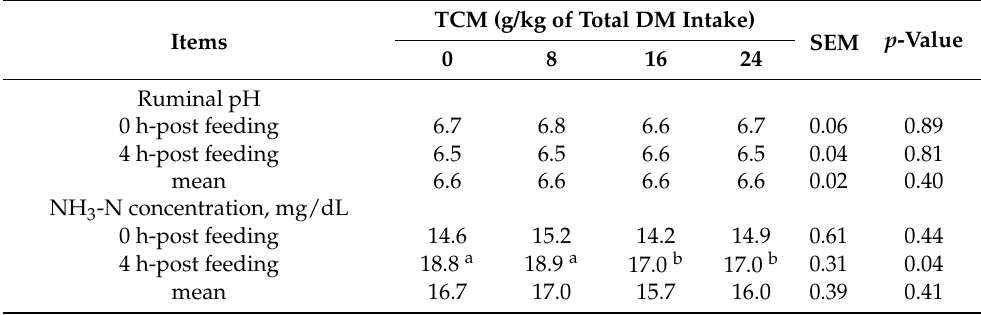
Table 3. Effect of Terminalia chebula meal (TCM) supplementation on ruminal pH, NH 3 -N, BUN concentration, and microbial